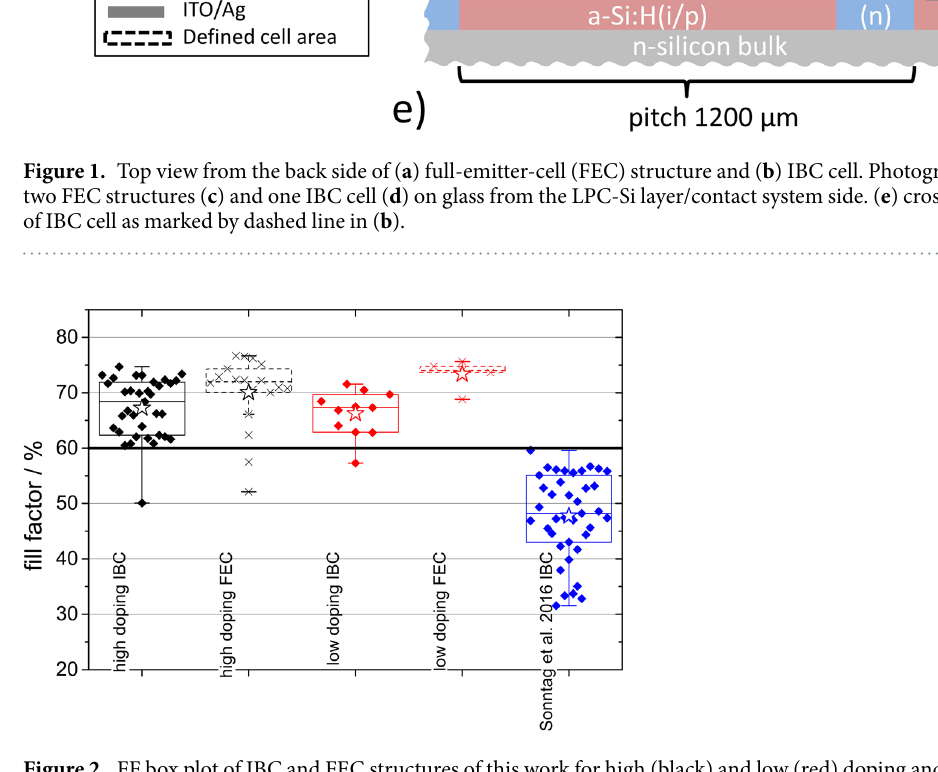
Figure 2. FF box plot of IBC and FEC structures of this work for high (black) and low (red) doping and FF of the cells fabricated in the course of the work from Sonntag et al . 2016 19 in